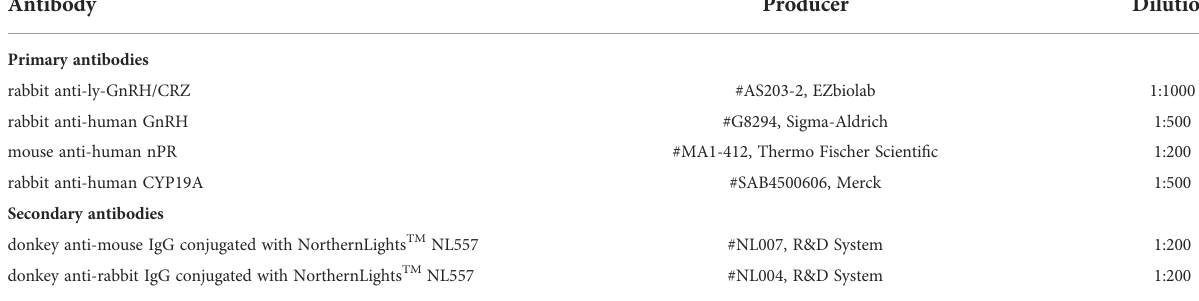
TABLE 2 Antibodies applied during the immunohistochemical and Western blot procedures.